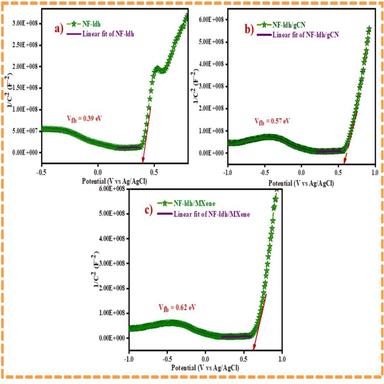
The calculation of flat-band potentials of (a) NF-ldh (b) NF-ldh/gCN (c) NF-ldh/MXene by the Mott-Schottky measurements.